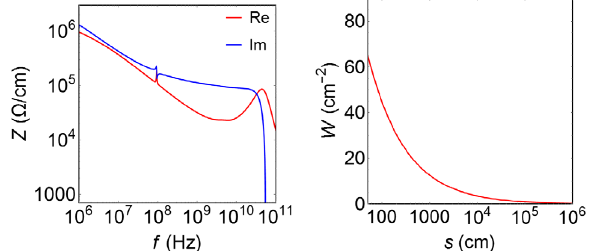
FIG. 7. Real and imaginary parts of the HL-LHC impedance (left) and the interbunch dipolar wake (right) at the top energy before the beams are brought into collision. Crab cavity HOMs not included. Horizontal plane, β (cid:1) ¼ 41 cm, E ¼ 7 TeV, ulti- mate operational scenario [26]. FIG. 8. The stability diagram for a quasiparabolic distribution